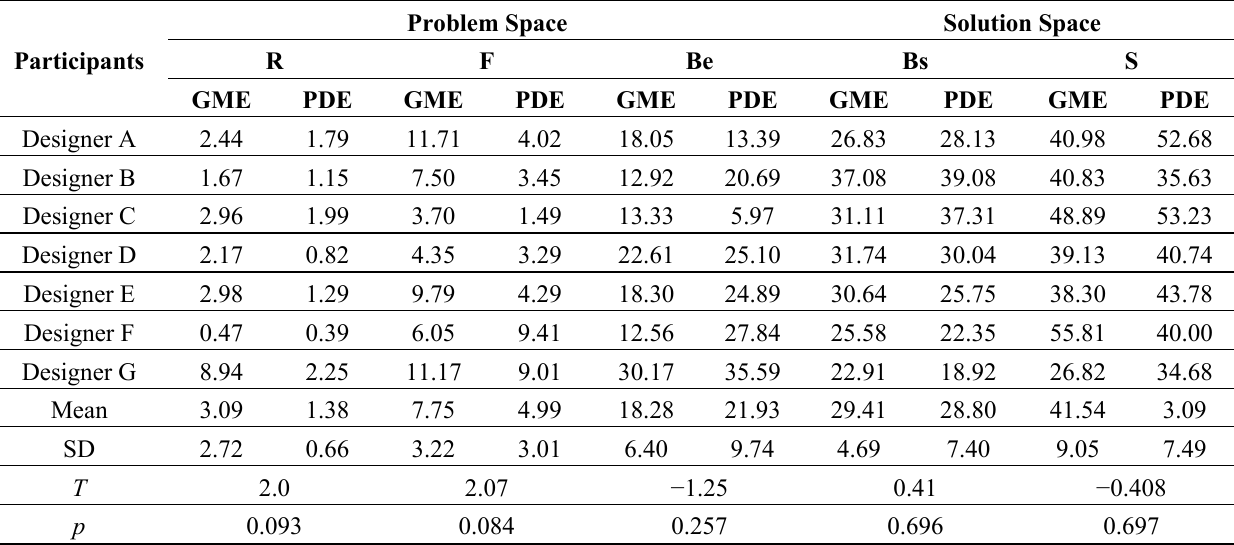
Table 3. Design issue distributions in GME and PDE.